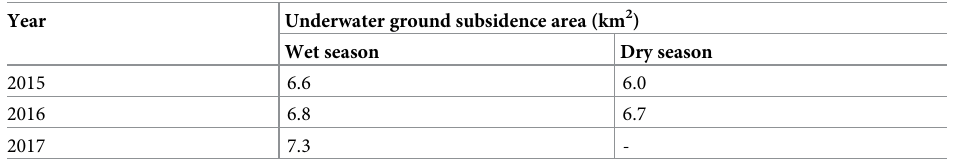
Table 2. Statistics of underwater ground subsidence